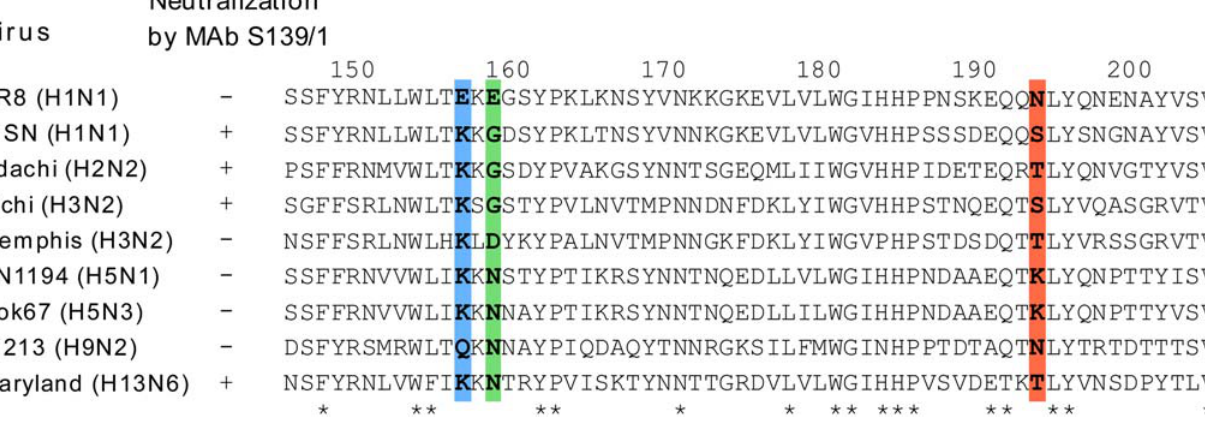
Figure 4. Comparison of the amino acid sequences of different subtypes of influenza A virus HAs. Amino acids at positions from 145 to 204 are shown. Boxed residues indicate the positions 156 (blue), 158 (green), and 193 (red). Asterisks indicate conserved amino acid residues among HA subtypes examined. Amino acid sequences for HAs, except Adachi (H2) and W213 (H9), were downloaded from the Influenza Virus Resource at the National Center for Biotechnology Information (NCBI) (http://www.ncbi.nlm.nih.gov/genomes/FLU/FLU.html) [48]. The NCBI accession numbers are CAA24272 (PR8), AAA43209 (WSN), AB432938 (Adachi), CAA24269 (Aichi), AAB63708 (Memphis), AAT7327 (VN1194), BAE48688 (Hok67), AB432937 (W213), and BAF46906 (Maryland).